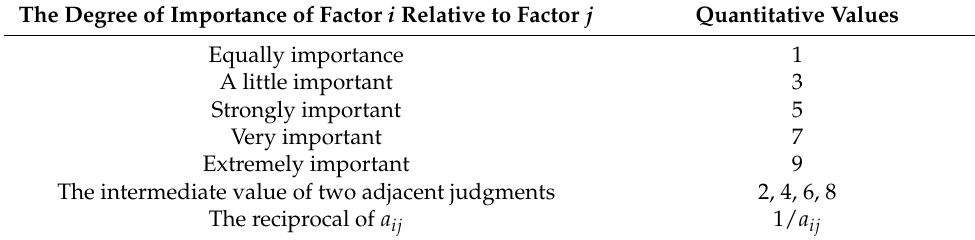
Table 1. Regulation Of Quantization Value. The Degree of Importance of Factor i Relative to Factor j Quantitative